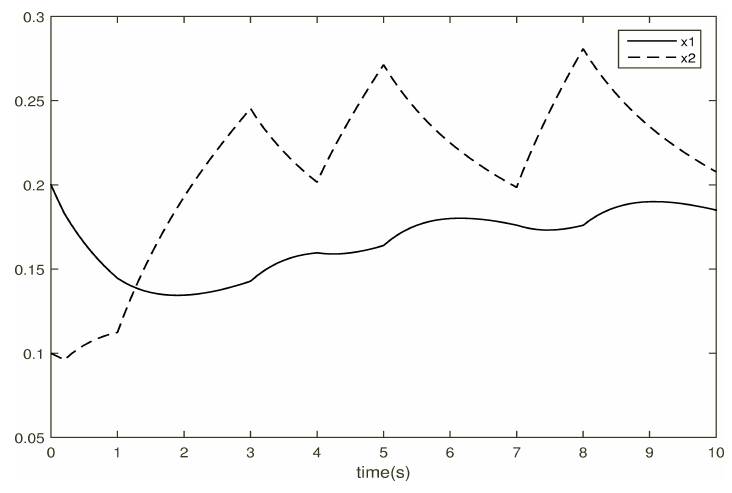
Fig. 4. State trajectories of closed-loop system (1).